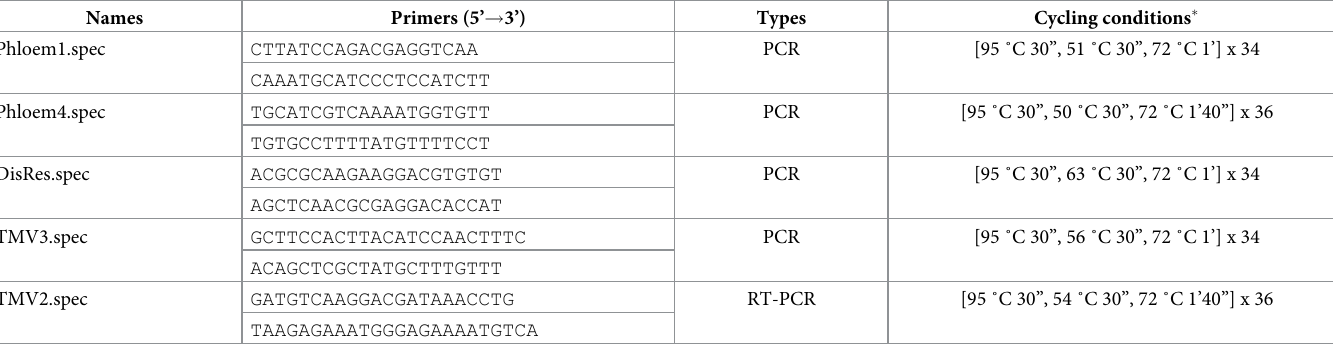
Table 1. NLR gene-specific markers of the Ry sto